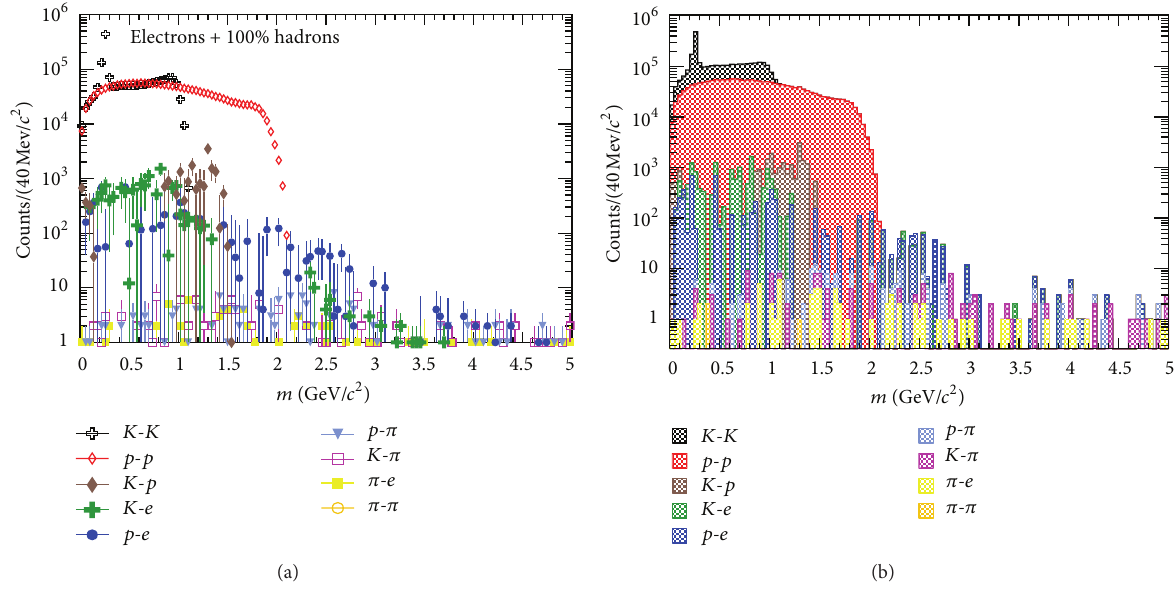
Figure 6: Correlated background induced by hadrons shown as (a) a mass distribution for each pair and (b) a cumulative (stacked) distribution broken down into its constituent